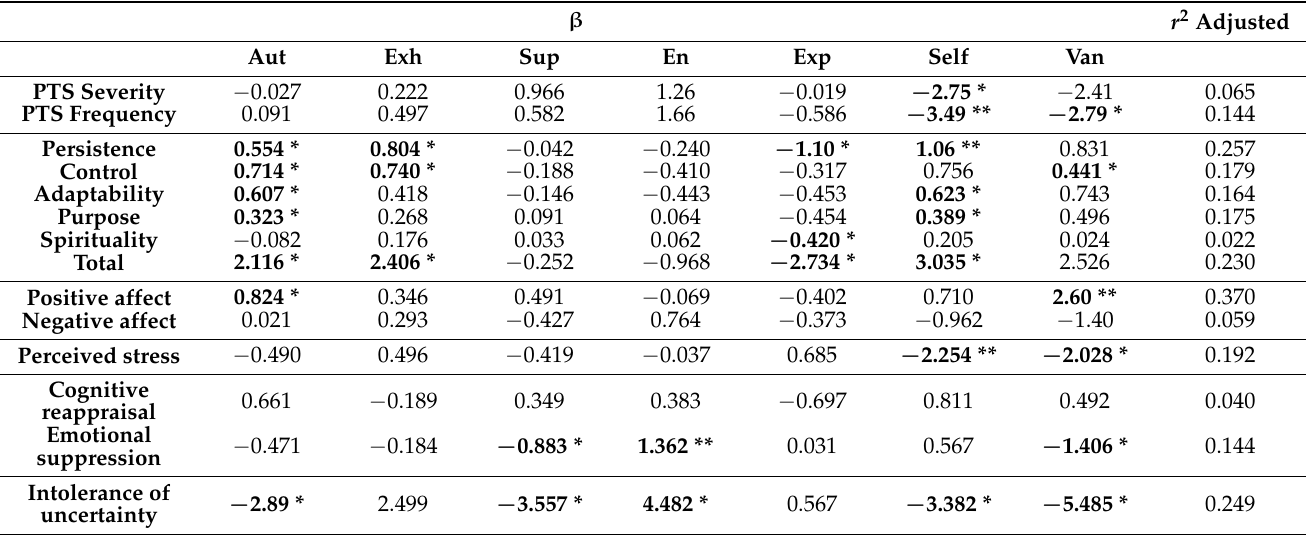
Table 3. Narcissistic personality traits as predictors of the outcomes of interest: Results of multiple regression analysis. β = unstandardized